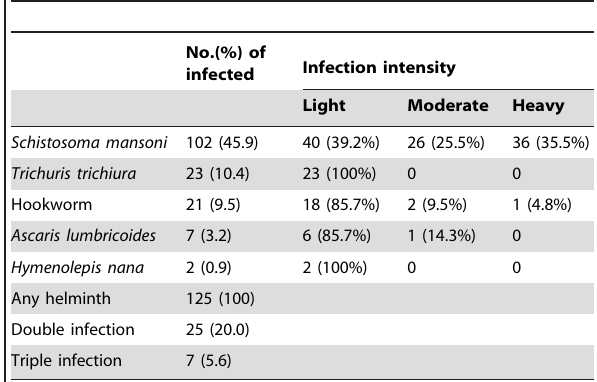
Table 1. Helminth prevalences and infection intensities among 125 helminth-positive study participants, from Azaguie´, Coˆte d’Ivoire, in